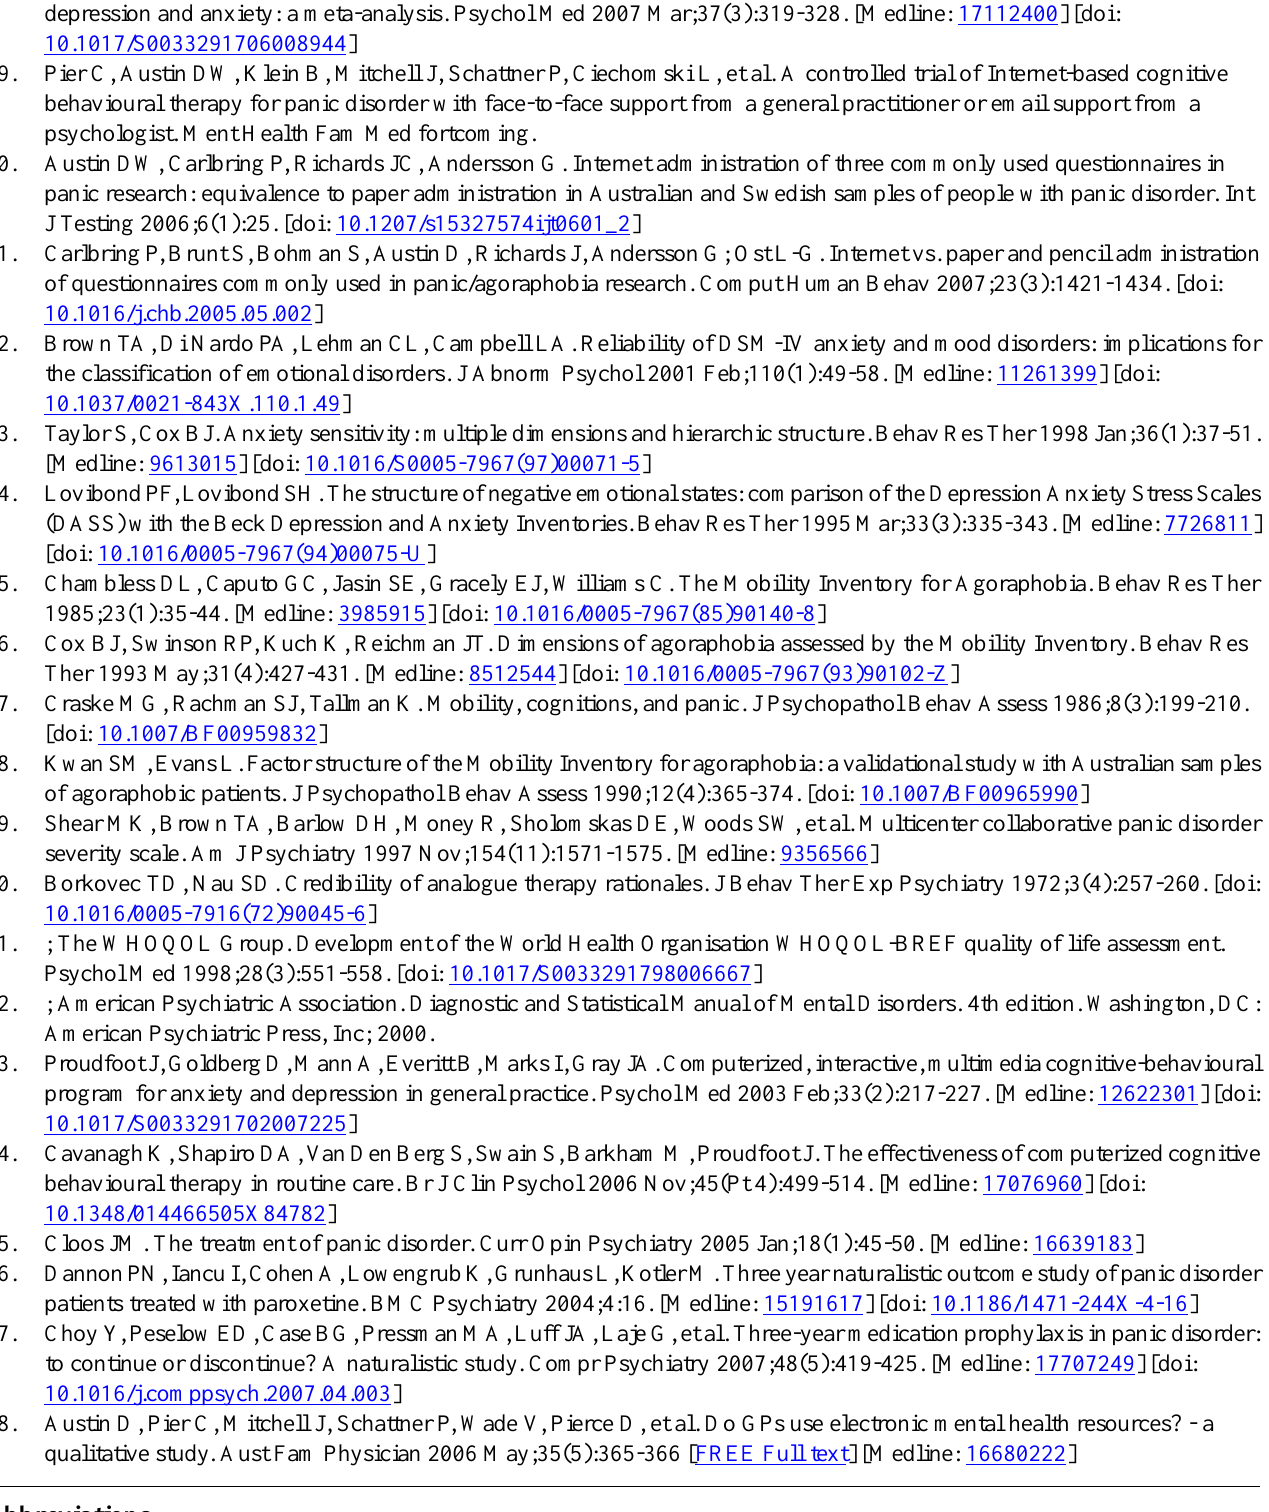
Abbreviations ASP: Anxiety Sensitivity Profile BOiMHC: Better Outcomes in Mental Health Care CBT: cognitive behavioral therapy DASS: Depression Anxiety Stress Scale GP: general practitioner MIA: Mobility Inventory alone